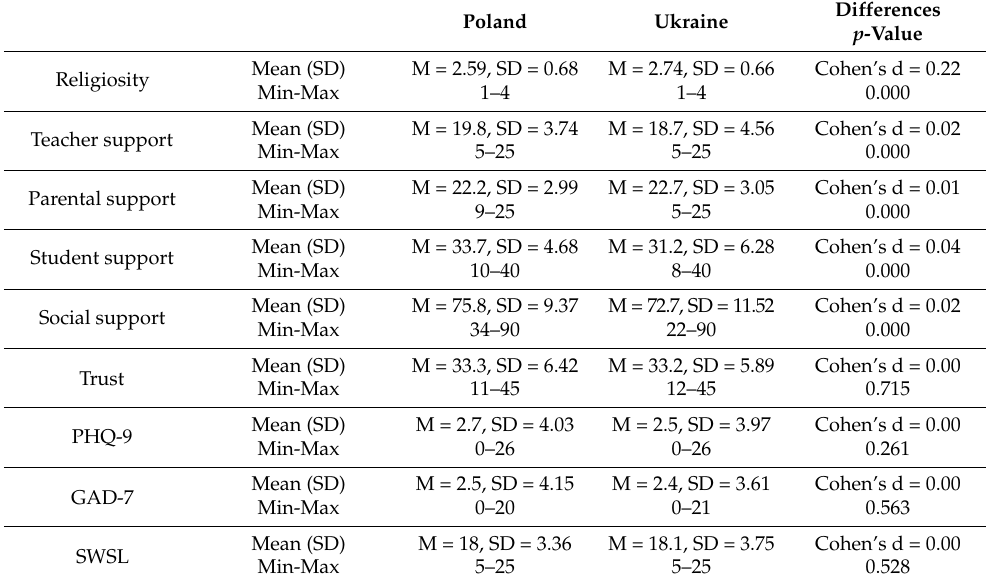
Table 2. Distribution of the values of the variables and the results of the t -test.